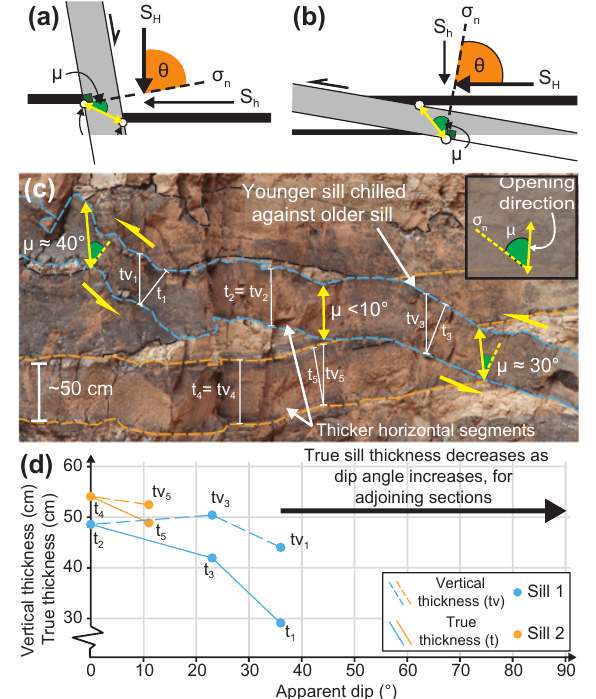
Figure 1. Schematic diagrams to show the dilation direction (yel- low arrow) and opening angle ( µ ) of fractures in different stress regimes: (a) normal-fault regime (where S H = σ v ); (b) thrust-fault regime (where S h = σ v ); the plane attitude is described by θ , the angle between the normal stress and the maximum stress. (c) Exam- ple of cross-cutting sills; the middle sill (outlined in blue) shows a consistent vertical opening direction: Mode I opening on horizontal planes and extensional-shear opening on inclined planes. (d) Graph showing changes in vertical thickness, tv, and true thickness, t , with changes of apparent dip, for the sills shown in panel (c)